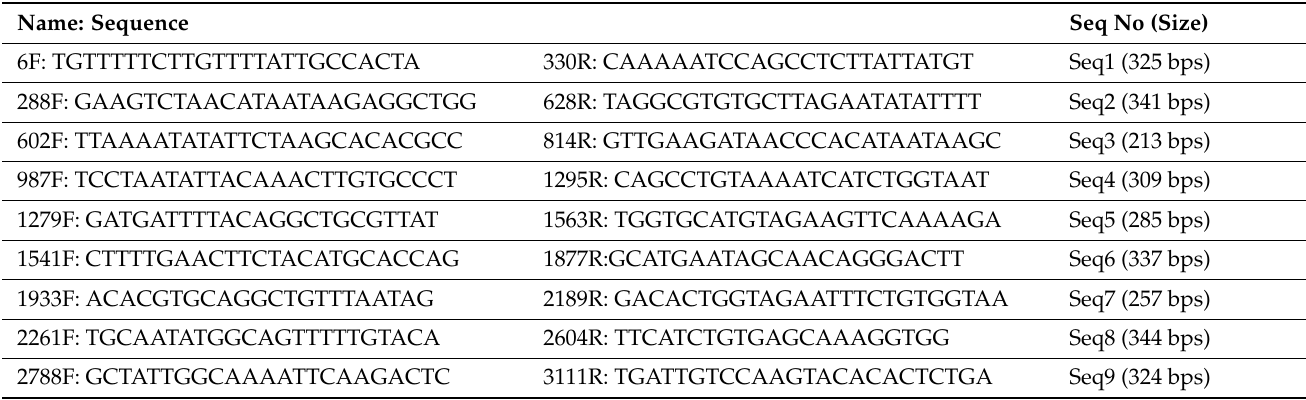
Table 2. The sequences of the primers for amplification and then Sanger sequencing of the 9 fragments of the S gene that might contain the reported